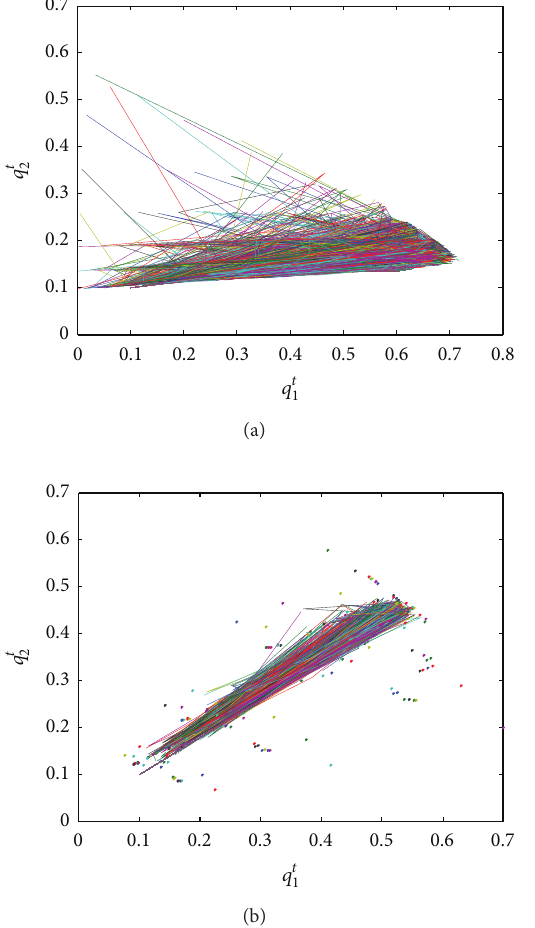
Figure 3: The relationship between 𝑞 𝑡 1 and 𝑞 𝑡 2 at the parameters: (a) = 2 , 𝜀 = 6 , and 𝛾 = 2.7694 ; (b) 𝑎 = 3 , 𝑎 = 3 , 𝑏 = 1.5 , 𝑐 = 0.3 , 𝜀 1 2 = 2 , 𝜀 = 6 , and 𝛾 = 0.7254 . 𝑏 = 1.5 , 𝑐 = 0.3 , 𝜀 1 2